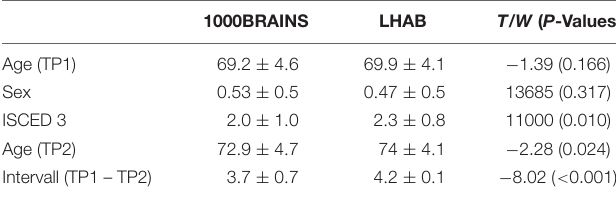
TABLE 1 | Demographics of the two samples and group comparisons (Independent T -test for continuous and Wilxon-Cox test for categorical variables) with corresponding T / W and p